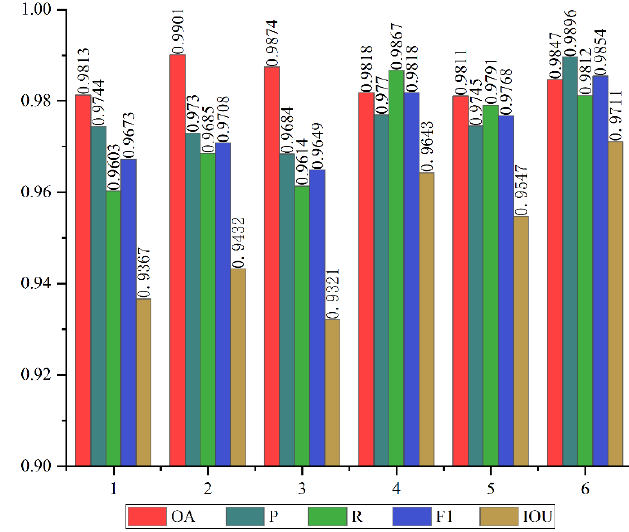
Figure 9. Evaluation results on the WHU building dataset.